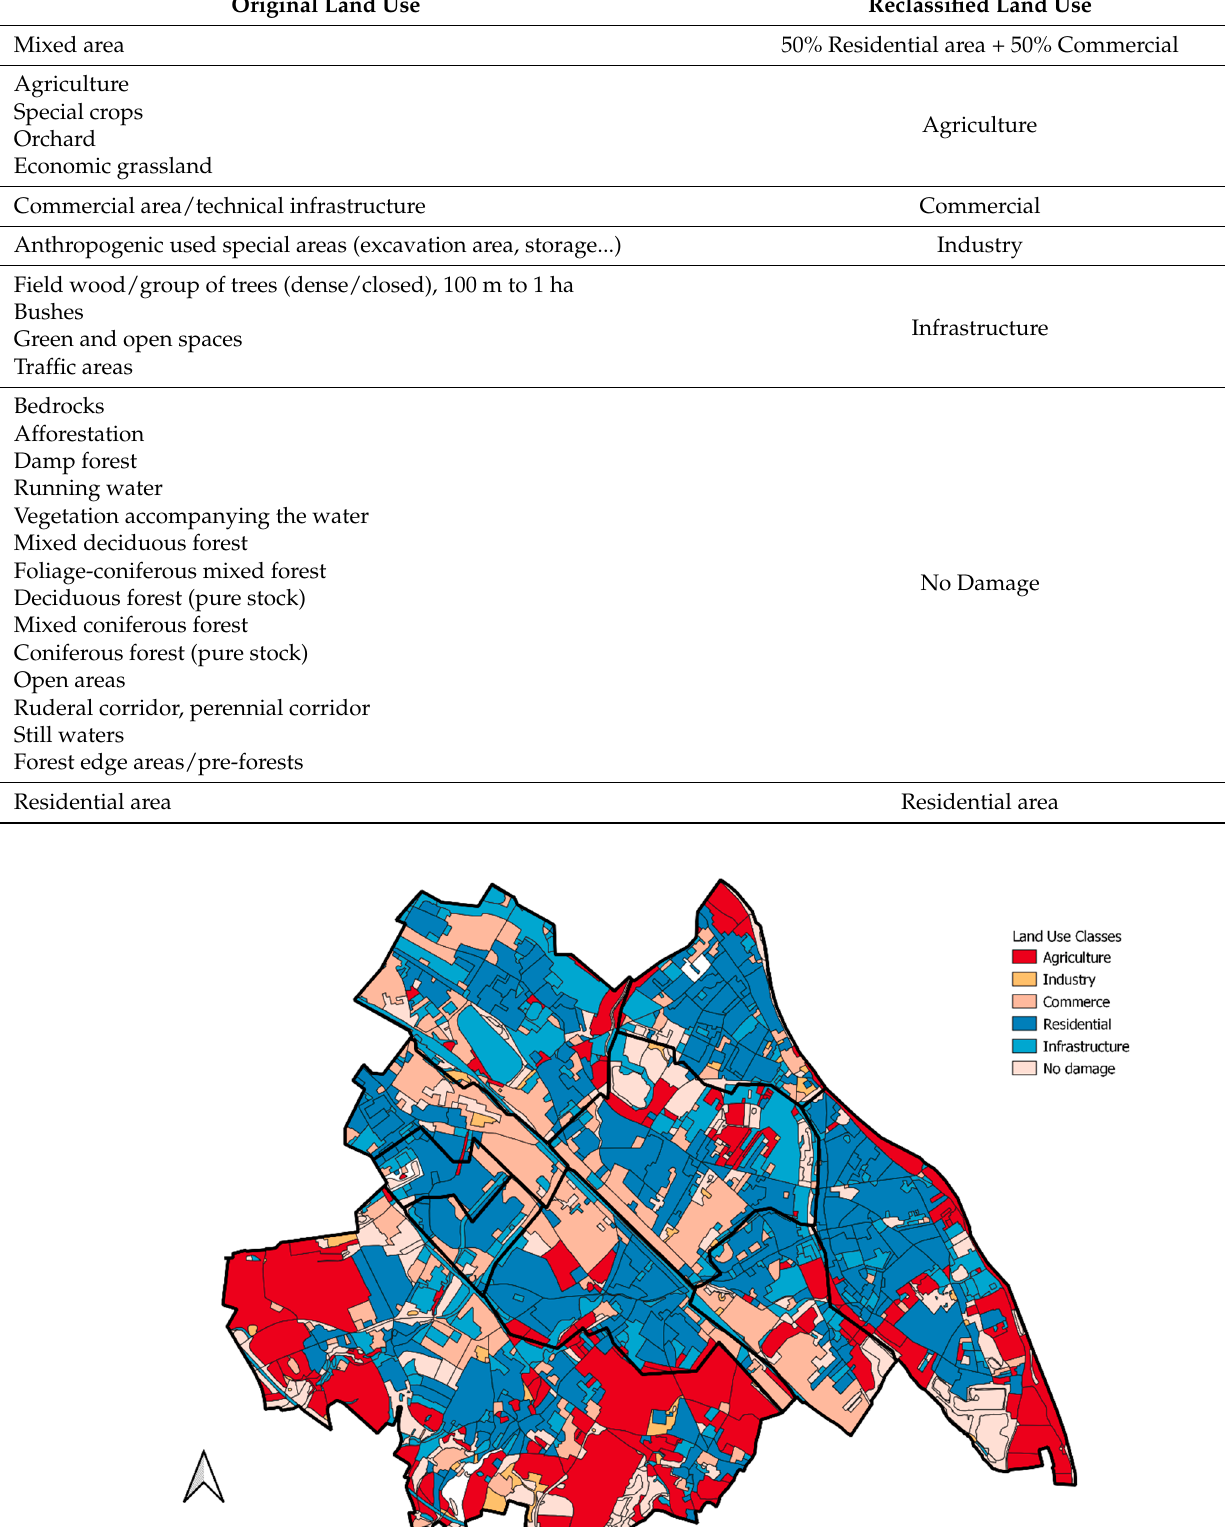
Table A1. Categories for land use reclassification.